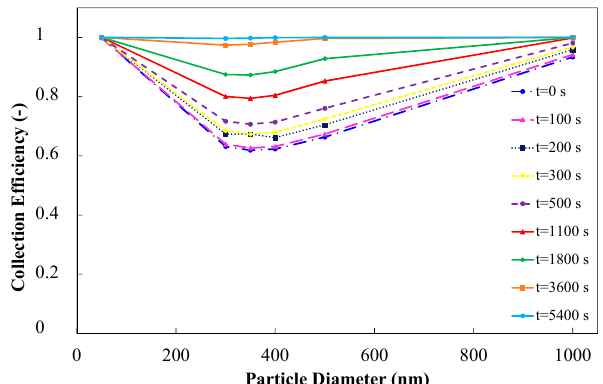
Figure 13. E ff ect of particle diameter on the variation of filter e ffi ciency with Figure 13. Effect of particle diameter on the variation of filter efficiency with time.